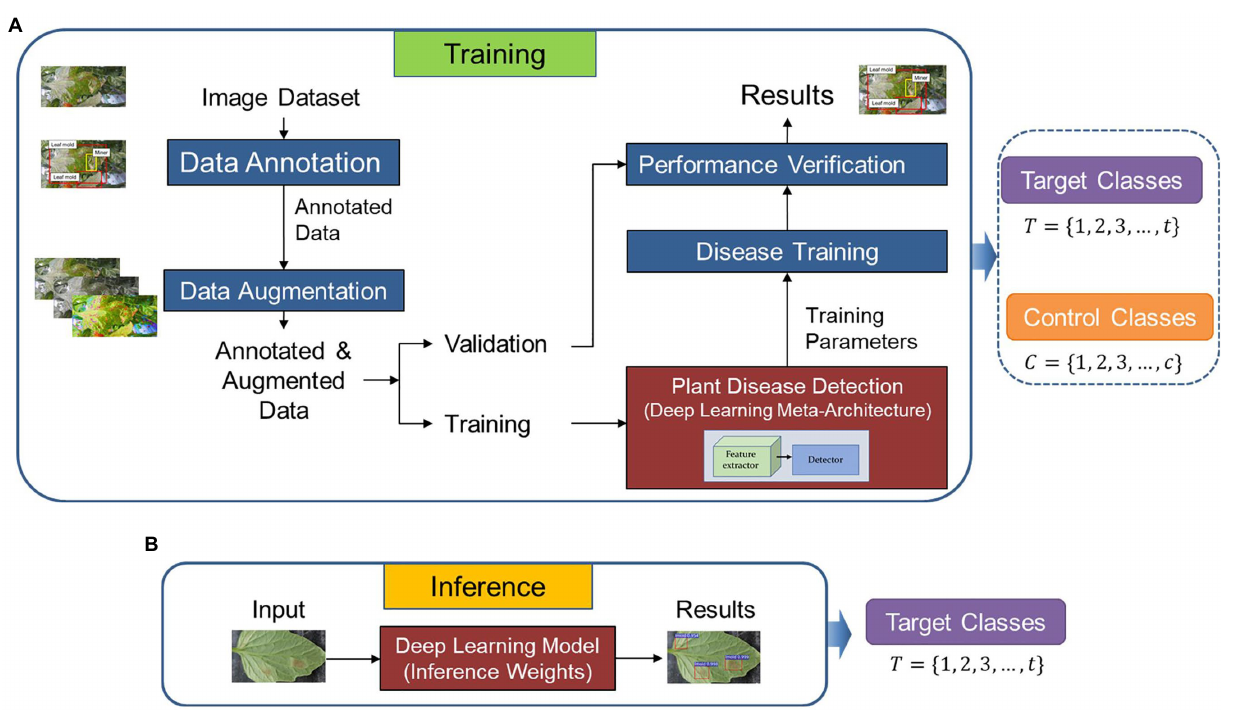
FIGURE 1 | Overall architecture of the proposed method. (A) Training and validation. (B) Inference. Control and target classes are used for training and validation. The weights of the model are used during inference but only focusing on the target classes as the recognition